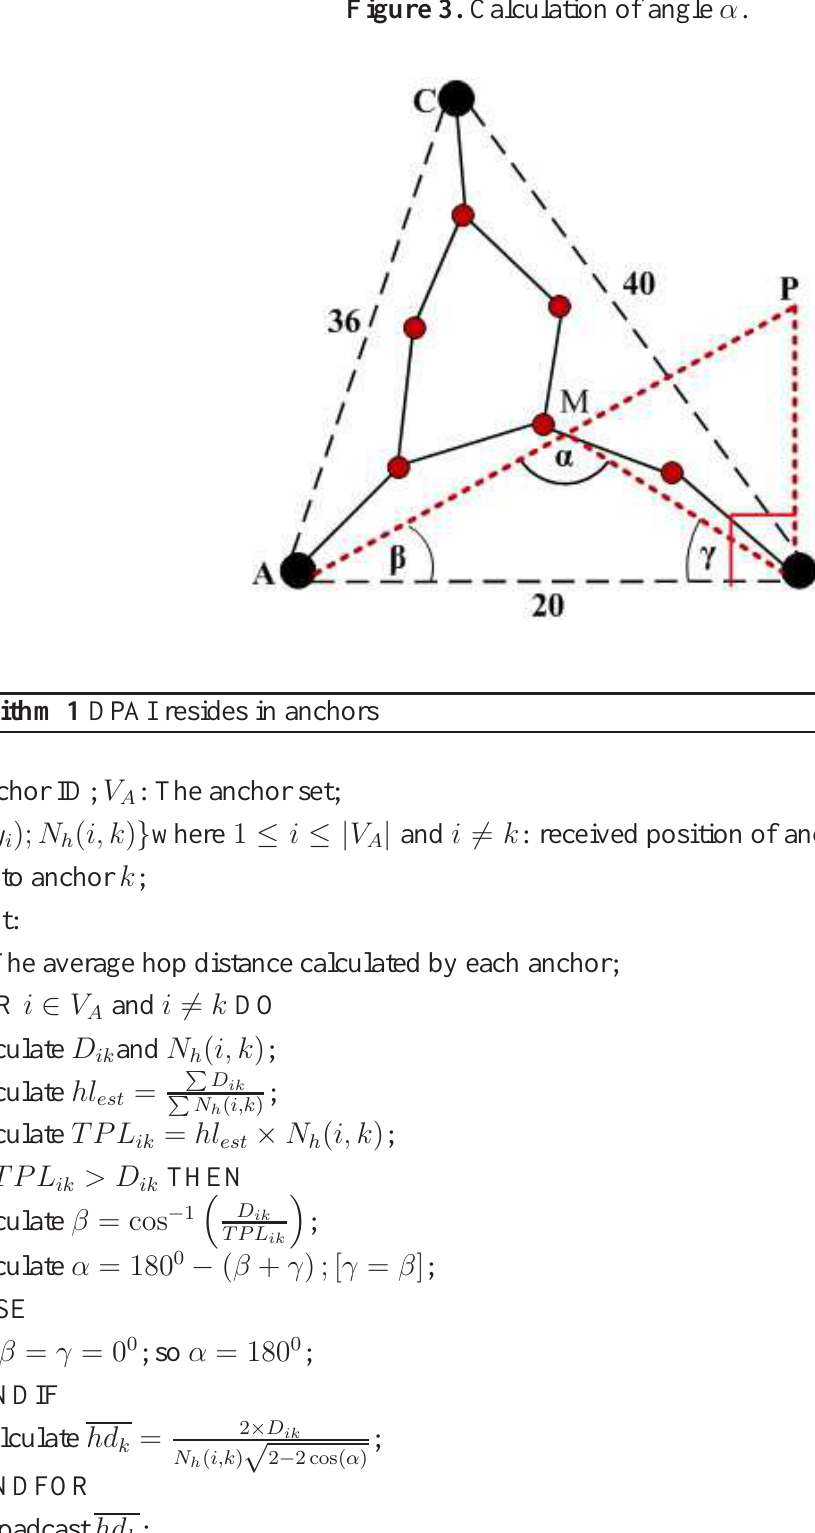
Figure 3. Calculation of angle α .